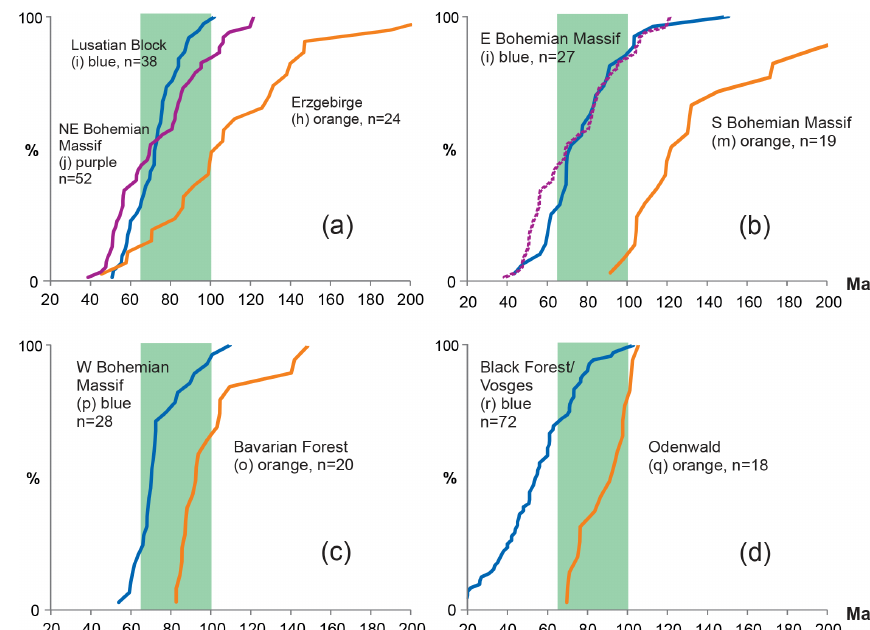
Figure 2. Cumulative frequency distributions of apatite fission-track data from various regions across central Europe. Characters in brackets refer to locations in Fig. 1; for references see the caption to Fig. 1. The stippled purple line in (b) is from the NE Bohemian Massif, like in (a) , for reference. The green area indicates the time interval of the Late